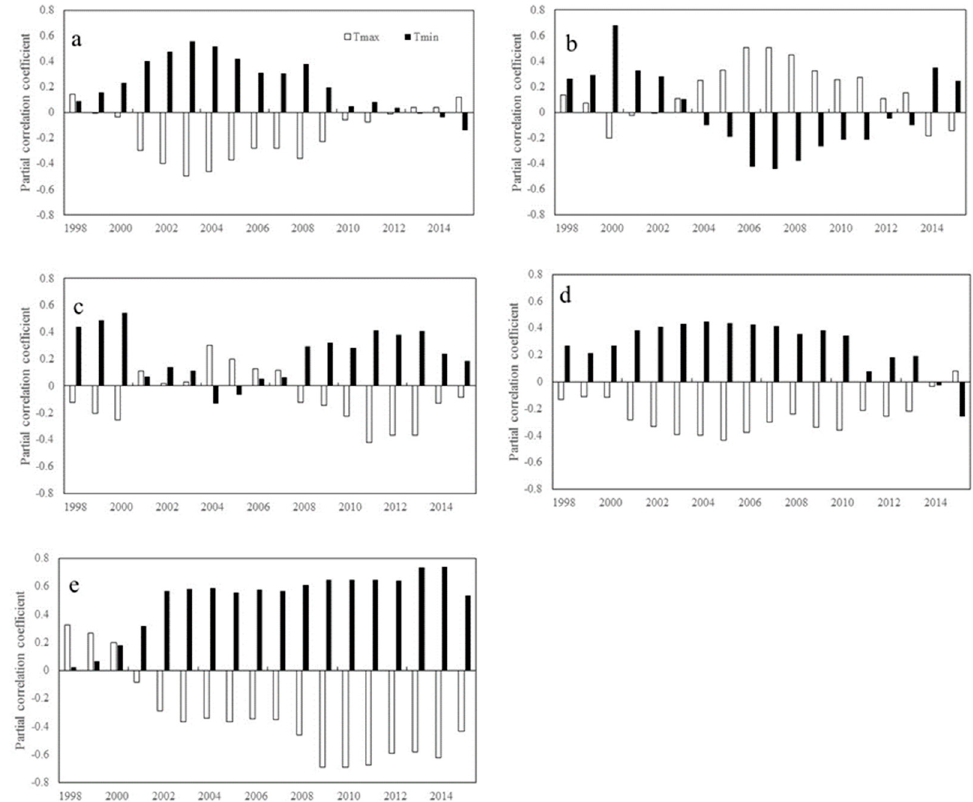
Figure 1. Temporal variations in the partial correlation coefficients between mean annual NDVI and the diurnal temperature (T max and T min ) for each 17-year moving window across latitudes intervals. ( a – e represents latitudes intervals at 60 ◦ ~90 ◦ N, 30 ◦ ~60 ◦ N, 0 ◦ ~30 ◦ N, − 30 ◦ ~0 ◦ S, and − 60 ◦ ~0 ◦ S, respectively (N and S indicates the Northern and southern hemisphere, respectively). The x axis is the last year of the 17-year moving-window (for example, 1998 stands for a moving-window from 1982 to 1998,…, 2015 stands for a moving-window from 1999 to 2015). The Y axis is the partial correlation coefficients).